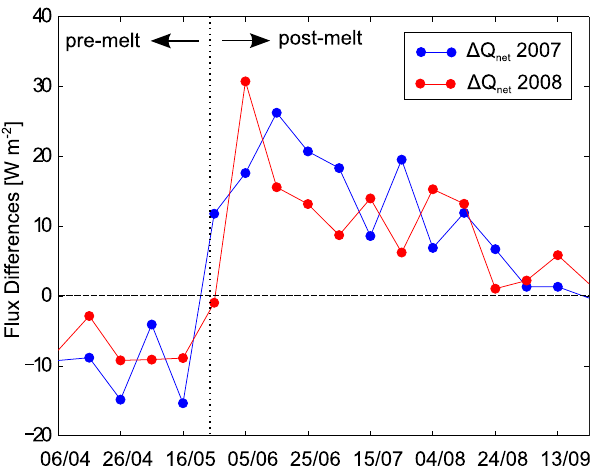
Fig. 7. Differences between the net radiation measured at the pond and the tundra surface 1Q net during the observation periods in 2007 and 2008.